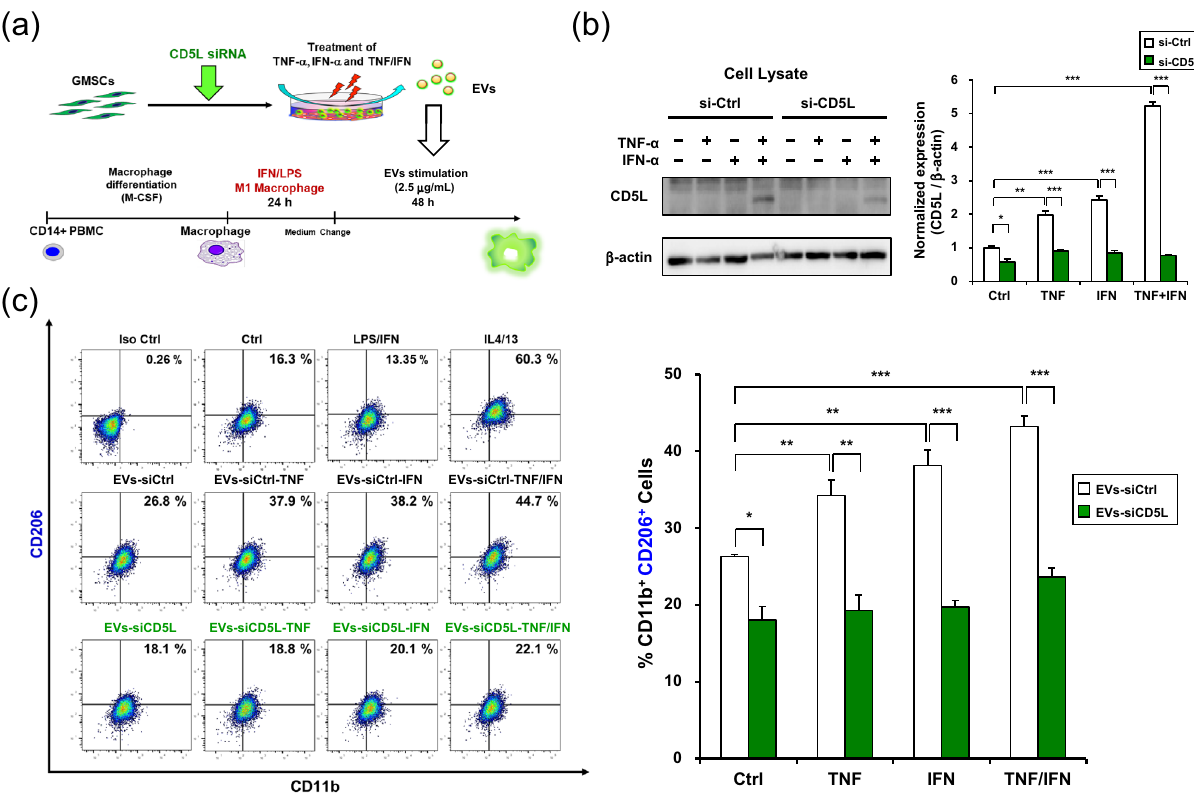
Figure 8. Effect of CD5L knockdown on TNF-α/IFN-α-stimulated GMSC-derived EVs -mediated M2 macrophage polarization. ( a ) Strategy diagram for the validation of phenotypic switching capacity of EVs from M1 to M2 macrophages. GMSCs were transfected with control (si-Ctrl) or CD5L siRNA (si-CD5L) for 48 h. EVs (2.5 µg/mL) from GMSCs transfected with either control (EVs-siCtrl) or CD5L siRNA (EVs-siCD5L) and subsequently stimulated with TNF-α (100 ng/mL; -TNF), IFN-α (100 ng/mL; -IFN), and TNF-α/IFN-α (50 ng/mL, each; -TNF/IFN) for 48 h were purified from each culture medium. After M1 macrophages were generated by LPS (10 ng/mL) and IFN-γ (25 ng/mL) stimulation from resting macrophages derived from CD14 + peripheral blood-derived monocytes (PBMCs), the GMSC-derived EVs were incubated with M1 macrophages for 48 h. ( b ) Whole-cell lysates of GMSCs prepared from culture conditions were subjected to immunoblot analysis with anti-CD5L antibody (left). β-actin was used as the control. Relative CD5L protein expressions were measured by quantifying the density of bands and normalized against β-actin using the MultiGauge software (right). ( c ) Effects of CD5L-siRNA-transfected GMSC-derived EVs on CD206 expression in macrophages. Percentage of double positive cells (CD11b + CD206 + ) was analyzed to measure the ratio of macrophages polarized to M2 phenotype. * P < 0.05; ** P < 0.01; *** P < 0.001. Error bars represent mean ± SD, n = 3. The significance of differences between groups was determined using one-way Tukey’s test. Full blots are presented in Supplementary